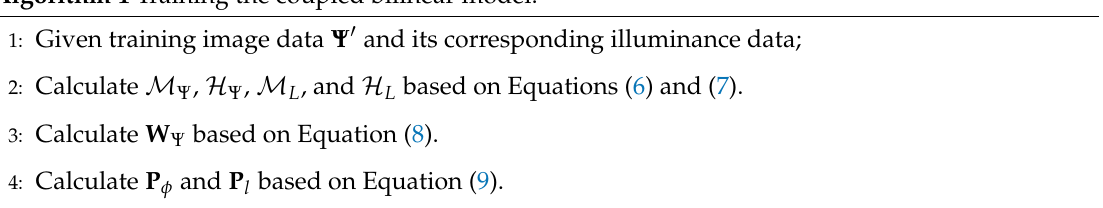
Algorithm 1 Training the coupled bilinear